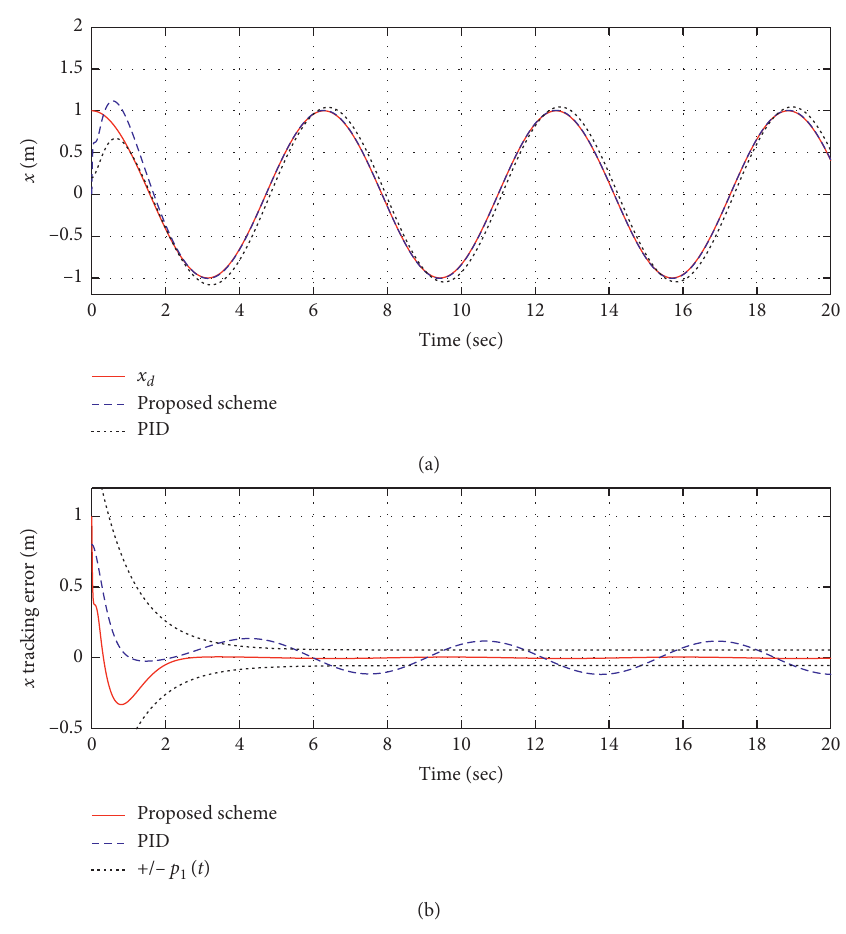
Figure 6: The tracking trajectory of x